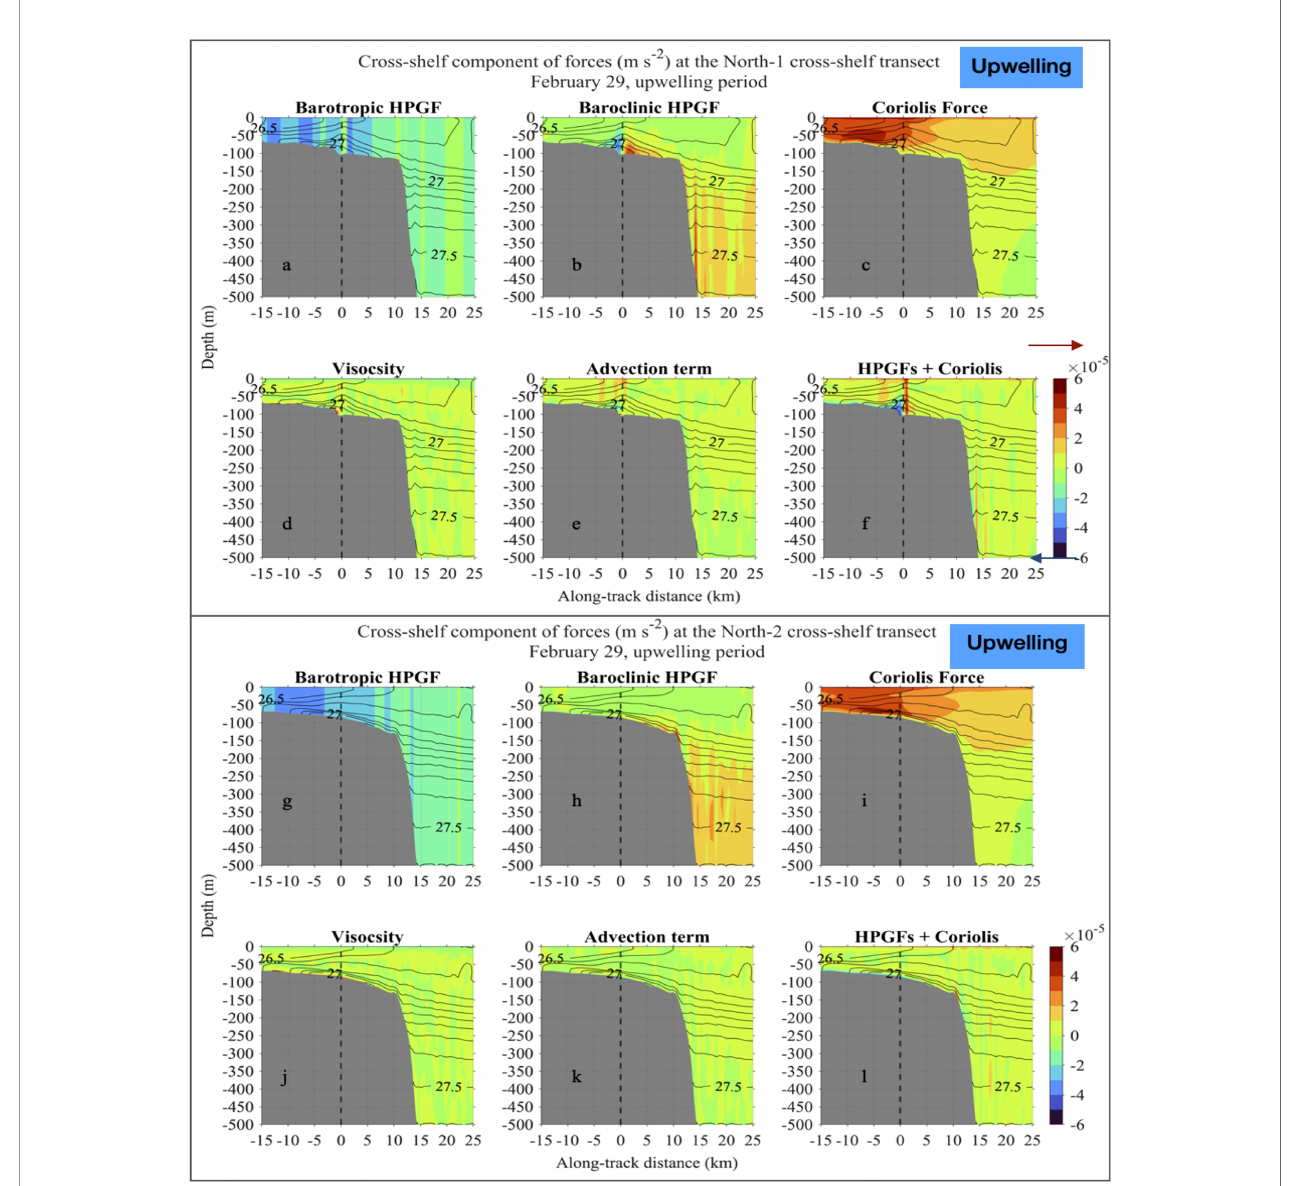
FIGURE 12 | Cross-shelf momentum balance for February 29, 2016 at the North-1 transect just northeast of the head of the canyon (A – F) and the North-2 transect 20 km northeast of the North-1 transect (G – L) . (A, G) Barotropic horizontal pressure gradient force. (B, H) Baroclinic horizontal pressure gradient force. (C, I) Coriolis Force. (D, J) Viscosity. (E, K) Advection. (F, L) HPGF +